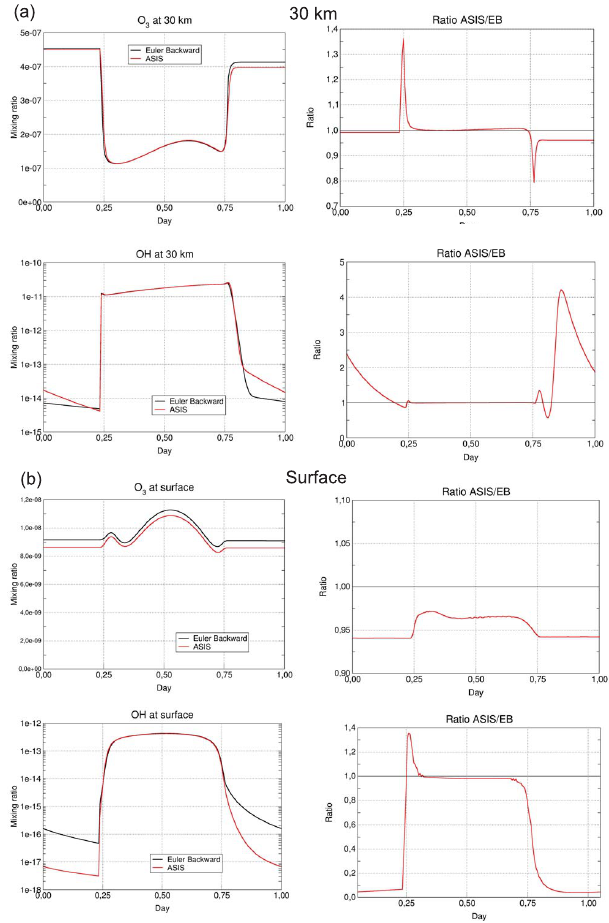
Figure 9. Comparison of the Euler-backward (EB) and ASIS solvers applied to the Mars box-model version. The left column shows the mixing ratios of O 3 and OH and the right one the ra- tio between the ASIS and EB experiments. Results are presented at 30km (a) and at the surface (b) , for equatorial conditions in north- ern spring (solar longitude Ls = 70 ◦ ). Local noon is at day